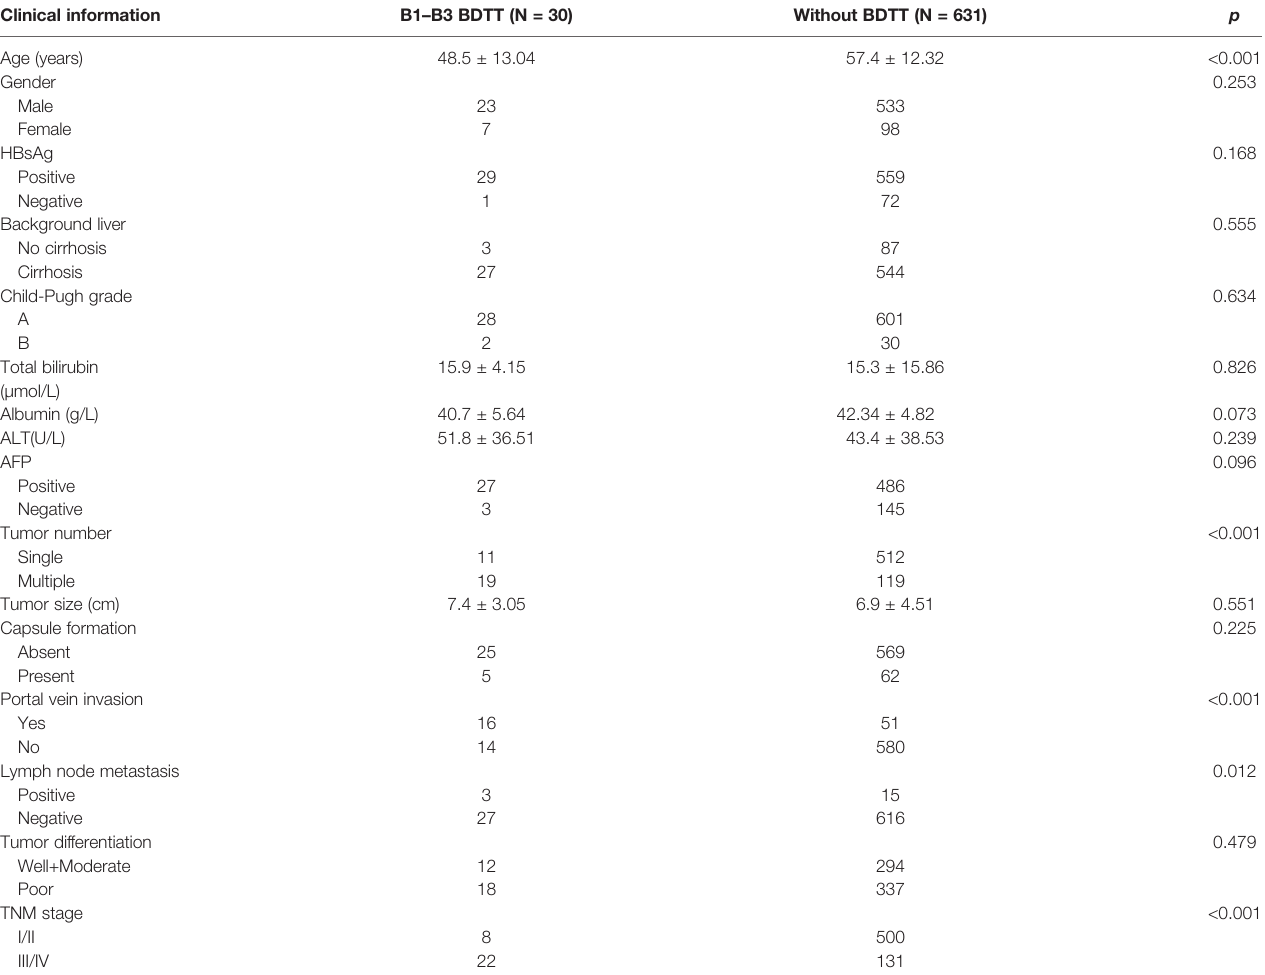
TABLE 1 | The clinicopathological feature of HCC patients with type B1 – B3 BDTT and without BDTT. Clinical